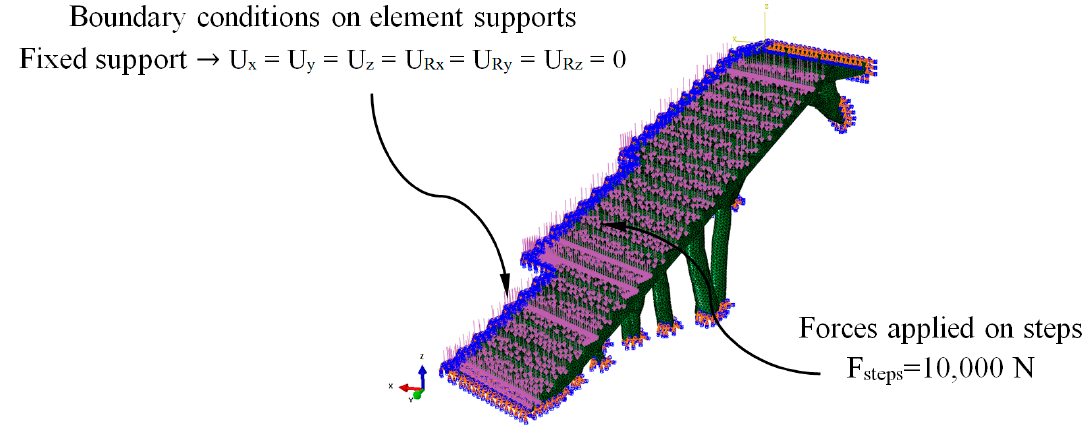
Figure 21. Load scenario and the boundary conditions of the numerical simulations for E 1 .